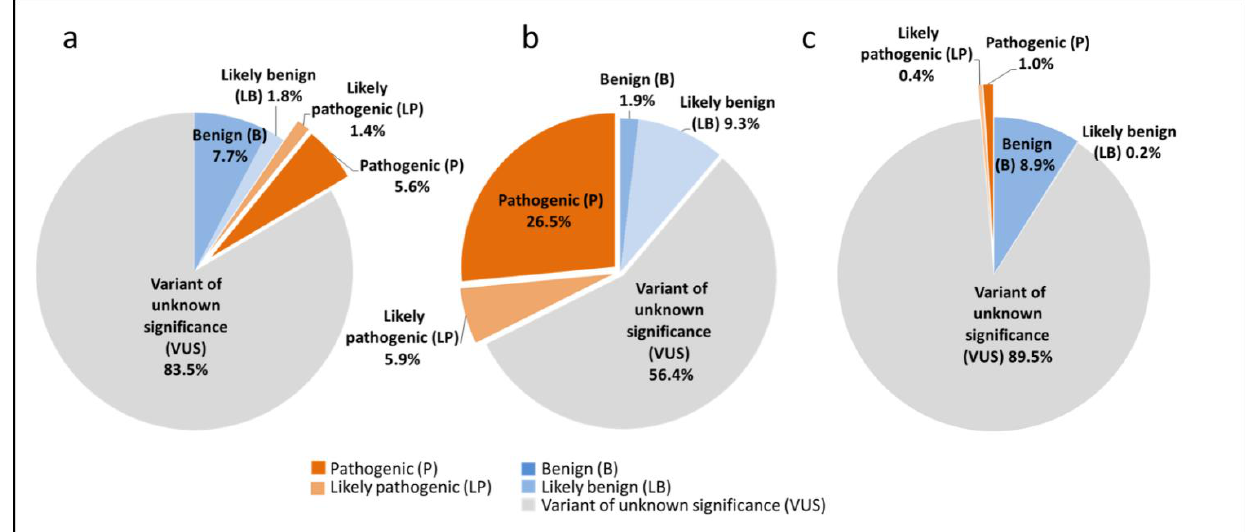
Figure 1. The proportions of different SLC26A4 variants (P, LP, VUS, LB and B). ( a ) Different types of variants in the entire SLC26A4 gene sequence. ( b ) Different types of variants in the SLC26A4 coding region. ( c ) Different types of variants in the SLC26A4 intronic regions.